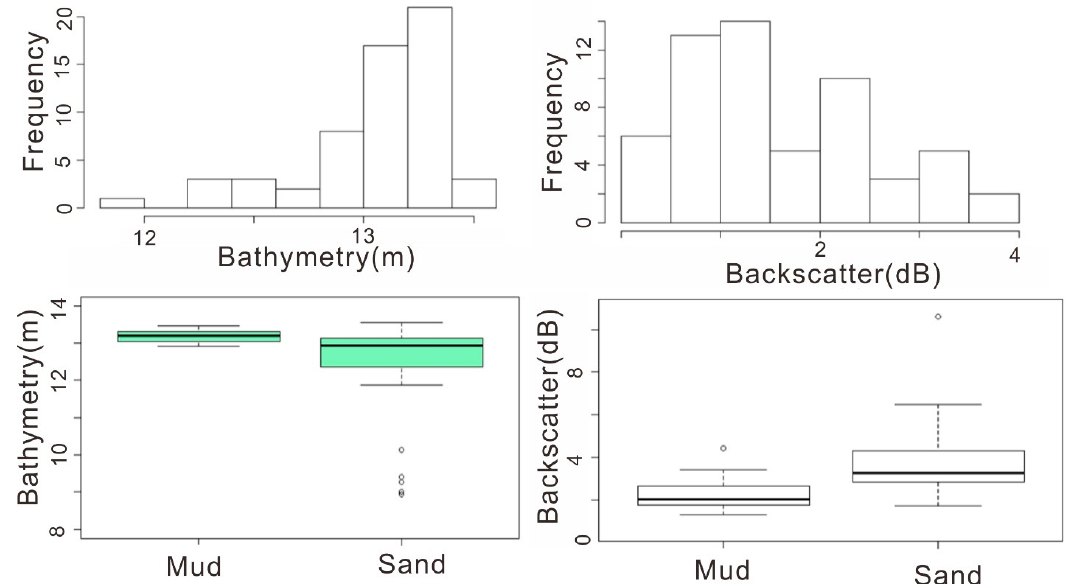
Figure 5. A summary of training data. ( A , B ) show the distribution of bathymetry values and backscatter values. ( C , D ) show the distribution of sediment types with bathymetric and backscatter values.